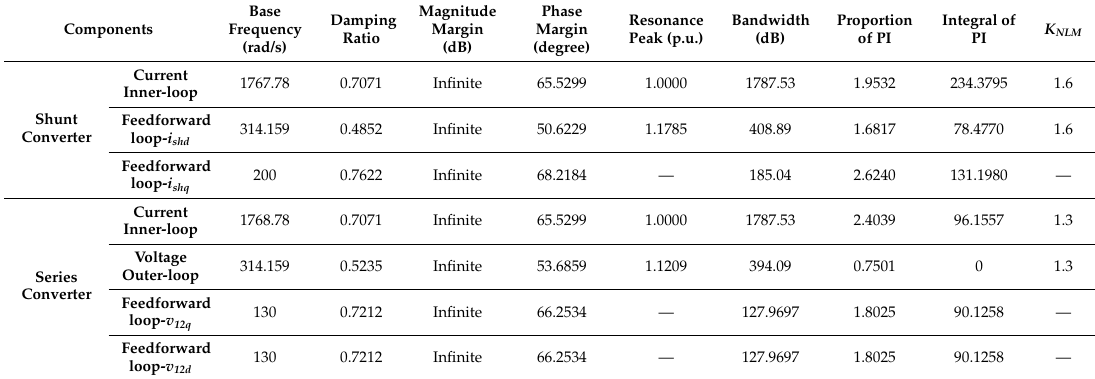
Table 2. The design parameters and performance of the control loops in complex domain.